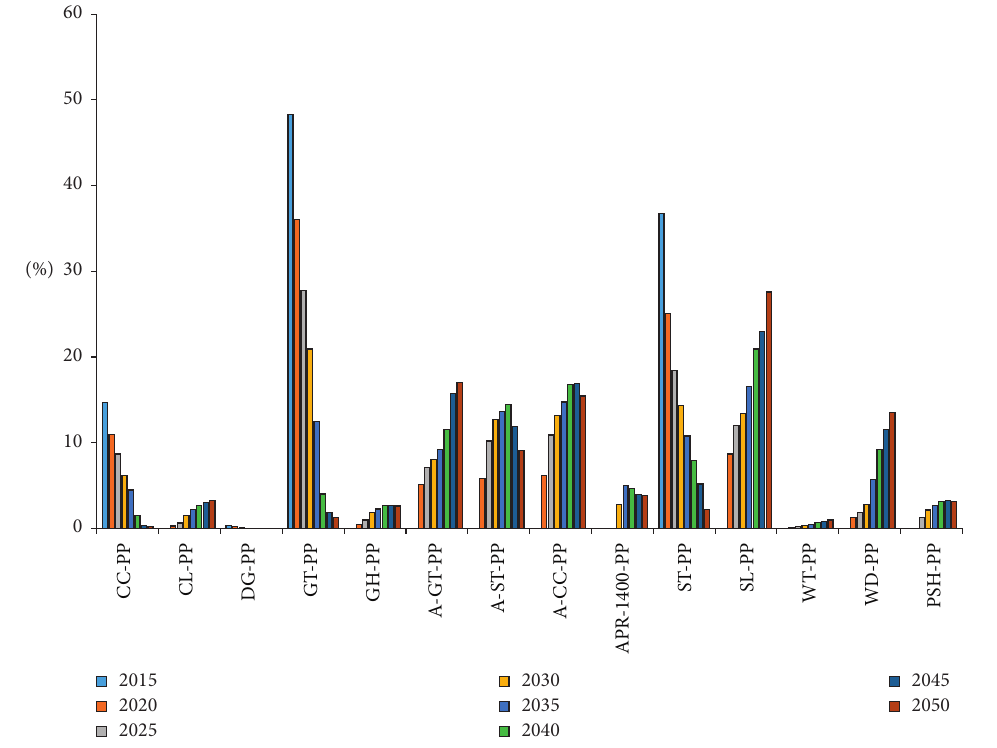
Figure 8: Share of power plant technologies for Subscenario III-1.